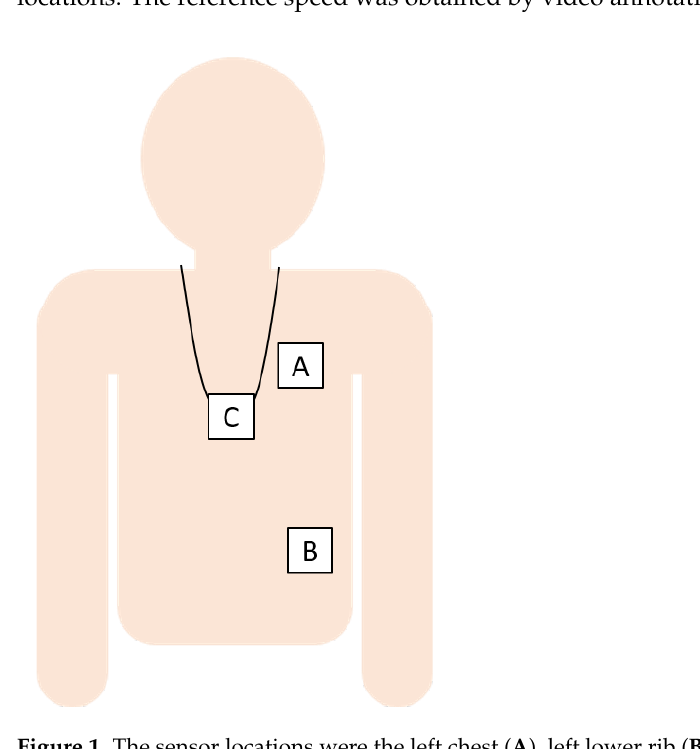
Figure 1. The sensor locations were the left chest ( A ), left lower rib ( B ), and pendant ( C ).